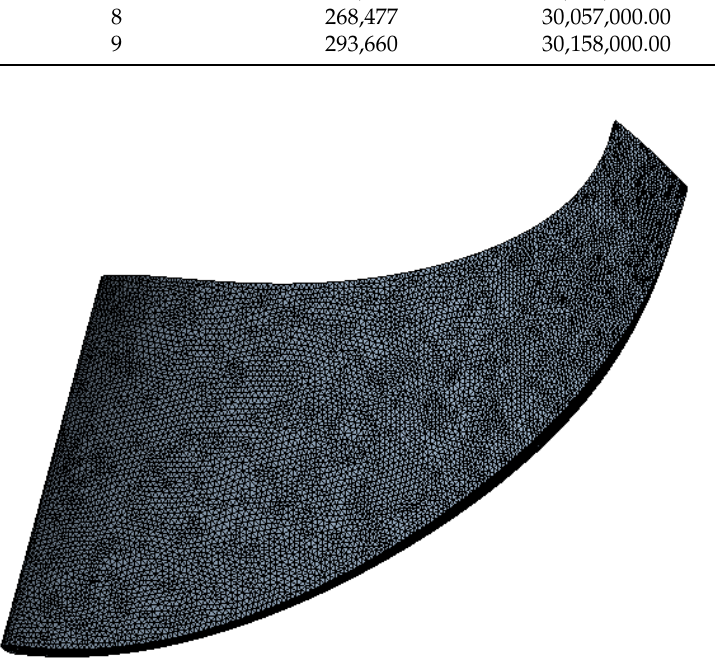
Figure 16. FEA mesh of point 8 in Table 5.